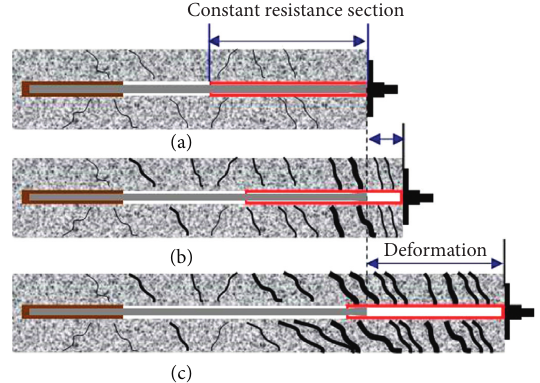
Figure 8: Principle of the anchor cable. (a) Before deformation. (b) Under deformation. (c) After deformation.